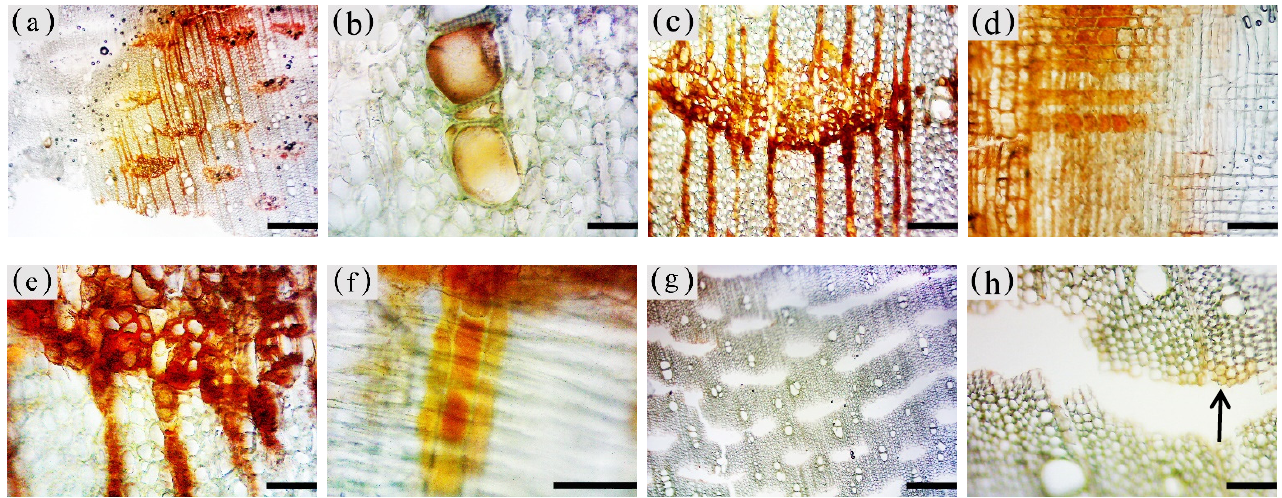
Figure 10. Color development of sesquiterpenoids in parenchyma cells of xylem of A. sinensis . ( a ) Color development of each zone in the transverse surface. ( b ) Vessel containing inclusions in the transverse surface of white zone. ( c ) Transverse surface of transition zone. ( d ) Radial surface of transition zone. ( e ) Transverse surface of agarwood zone. ( f ) Radial surface of agarwood zone. ( g ) Transverse surface of decay zone. ( h ) Transverse surface of decay zone, the edges of the undecayed interxylary phloem at the arrows are showing color. Scale bars = ( a , g ) 500 µm; ( b , e – f ) 50 µm;( c , d , h ) 200 µm.